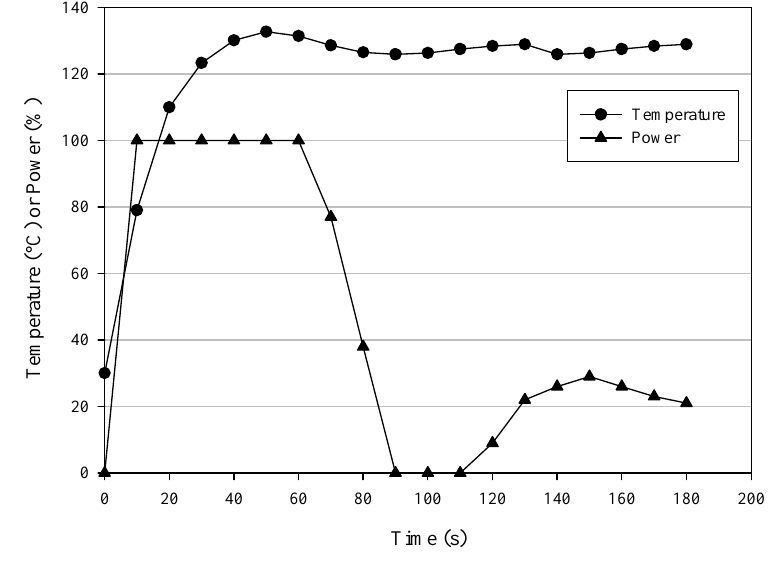
Figure 2. Graph of temperature and power % vs time for the synthesis of pyrazole a following MW2 synthetic approach under the entry F (Table 2) operative